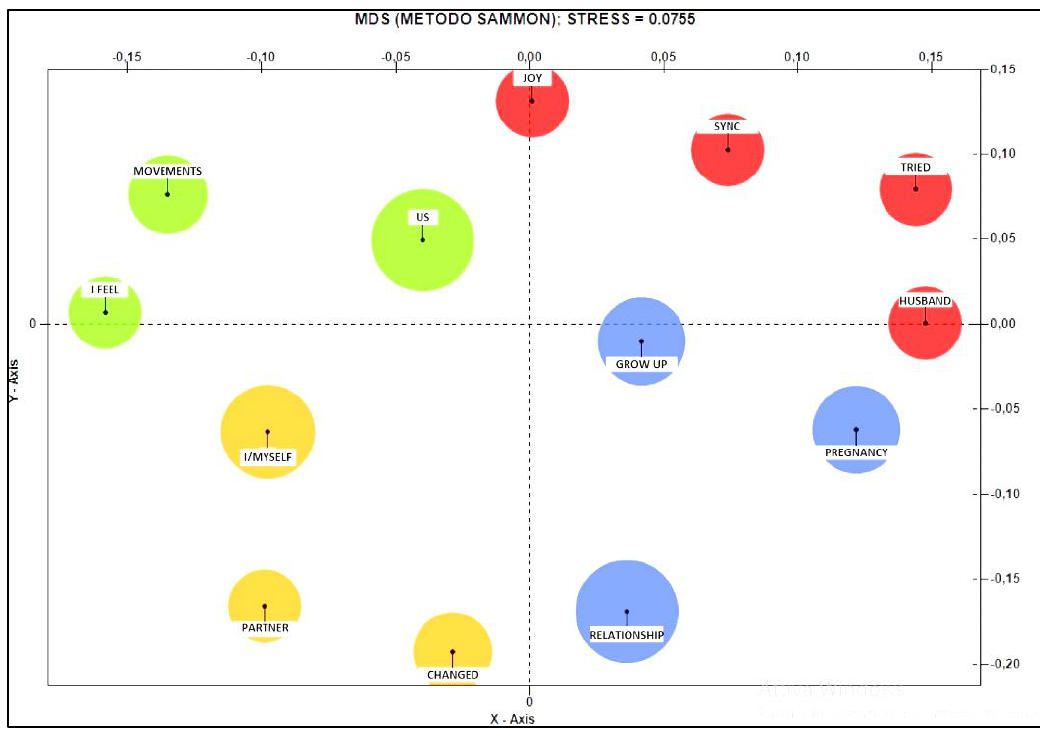
Figure 6. Co-word Analysis referring to the theme “perception of self and with other significant”. The fourth main theme is “future” and combines IRMAG’s answers to questions 8